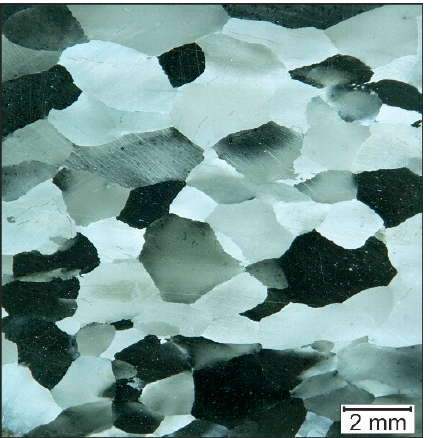
Figure 7. Microstructure of Fe28Al before ECAP forming.